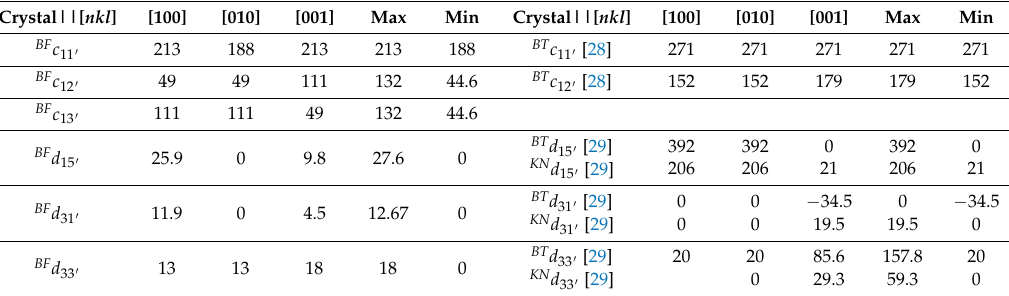
Figure 7. ( a ) Schematic diagram of piezoelectric constant d 33 by the experimental data of BiFeO 3 ; ( b ) piezoelectric constant d 33 of BiFeO 3 in XOZ plane at φ = 0 ◦ ; ( c ) piezoelectric constant d 33 of BiFeO 3 in X ’ OZ plane at φ = 60 ◦ (unit 10 − 12 C/N). Table 1. Comparison of elastic stiffness c ij (cid:48) (GPa) and piezoelectric constant d ij (cid:48) (10 − 12 C/N) and their extremums along chosen orientations among BiFeO 3 ( 3m ), tetragonal BaTiO 3 ( 4mm ), and KNbO 3 ( m2m ) [28,29] #